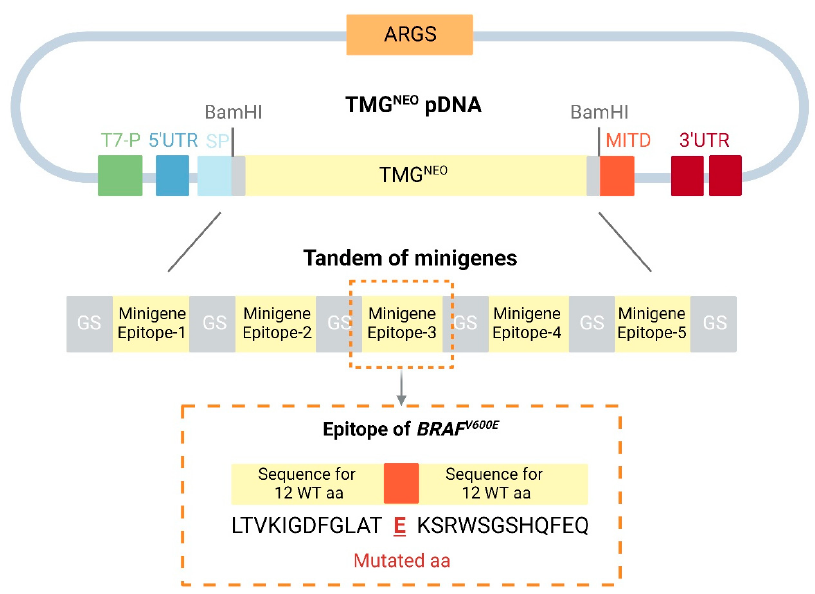
Figure 7. Design for TMG NEO pDNA. Abbreviations: ARGS, antibiotic resistance genes; T7-P, T7 promoter; SP, signal peptide; TMG, tandem of minigenes; MITD, the trafficking domain of major histocompatibility complex class I; GS, glycine/serine linker.